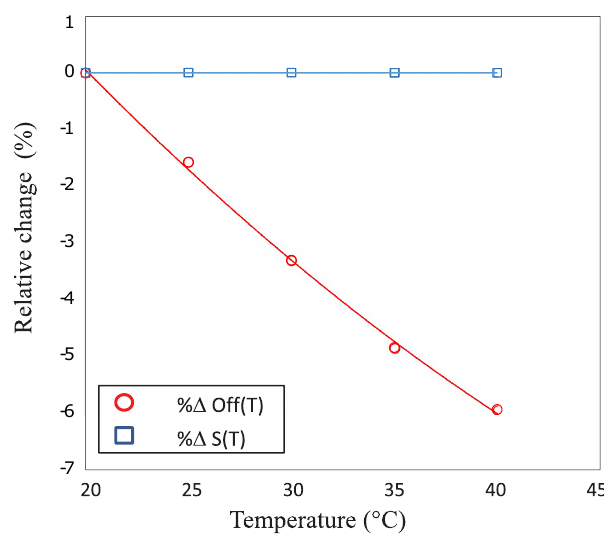
Figure 9. Offset (red, circle) and sensitivity (blue, square) relative changes as a function of